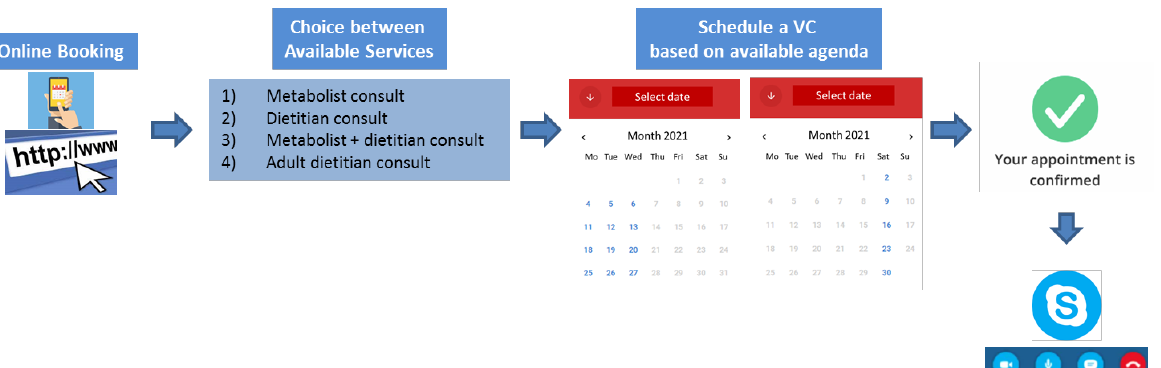
Figure 2. Online flow used for video consulting online assessments and dedicated agenda, including Skype ® platform use upon acquisition of signed informed consent and the different types of possible consult available.